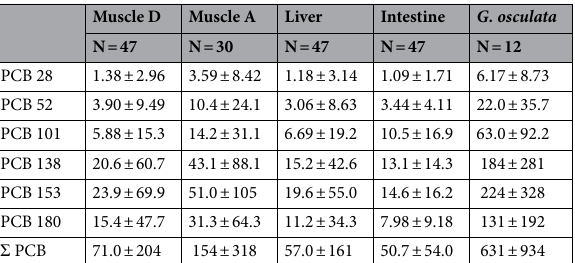
Table 1. Mean concentrations of individual PCB congeners and their sum (mean ± SD) in fish and their parasites (ng g −1 w.w.) from four examined localities.